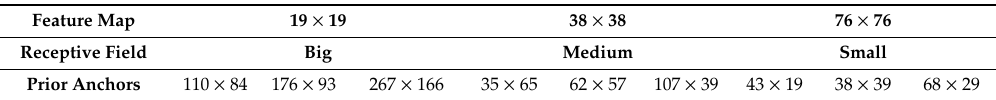
Table 1. The feature map and prior anchors of Singapore Marine Dataset (SMD) and PETS 2016 maritime dataset. A total of nine anchors were used to generate bounding boxes, and the size of prior anchors was calculated by the k-means